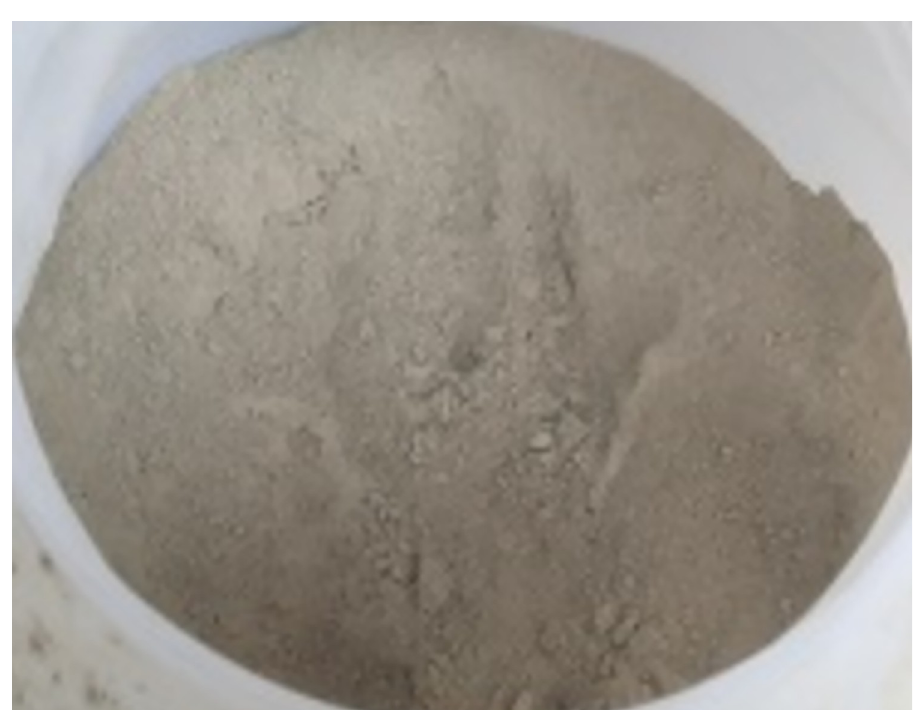
Fig 1. Sulphoaluminate cement clinker.